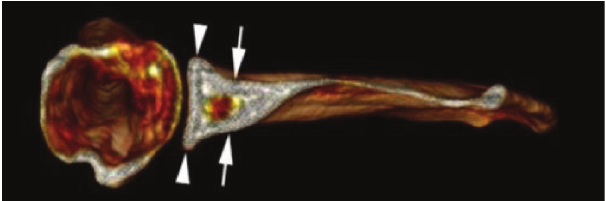
Figure 1. Maximal width (arrowhead) and minimum width (arrow).